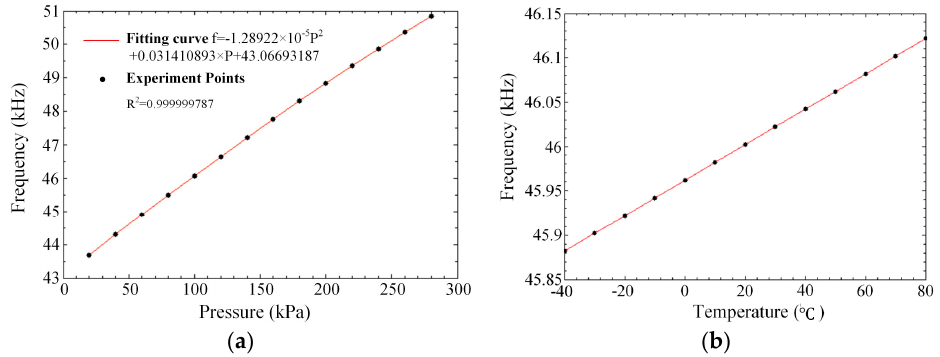
Figure 12. The calibration system for the sensor.